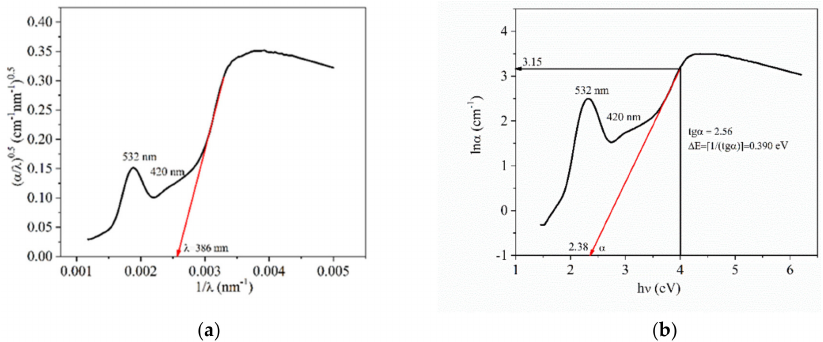
Figure 3. ( a ) Variation of ( α / λ ) 0.5 with 1 / λ ; and( b ) Urbach plot for Te-5